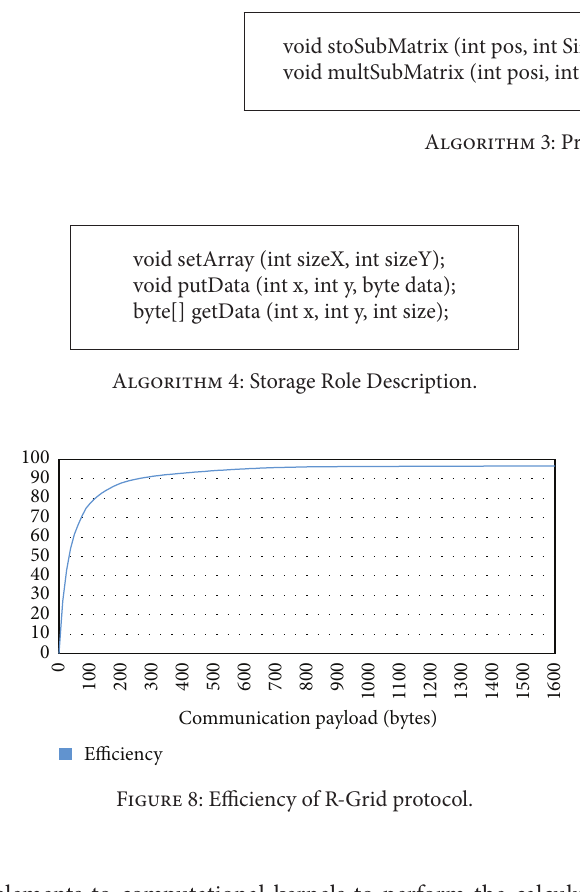
Figure 8: Efficiency of R-Grid protocol.